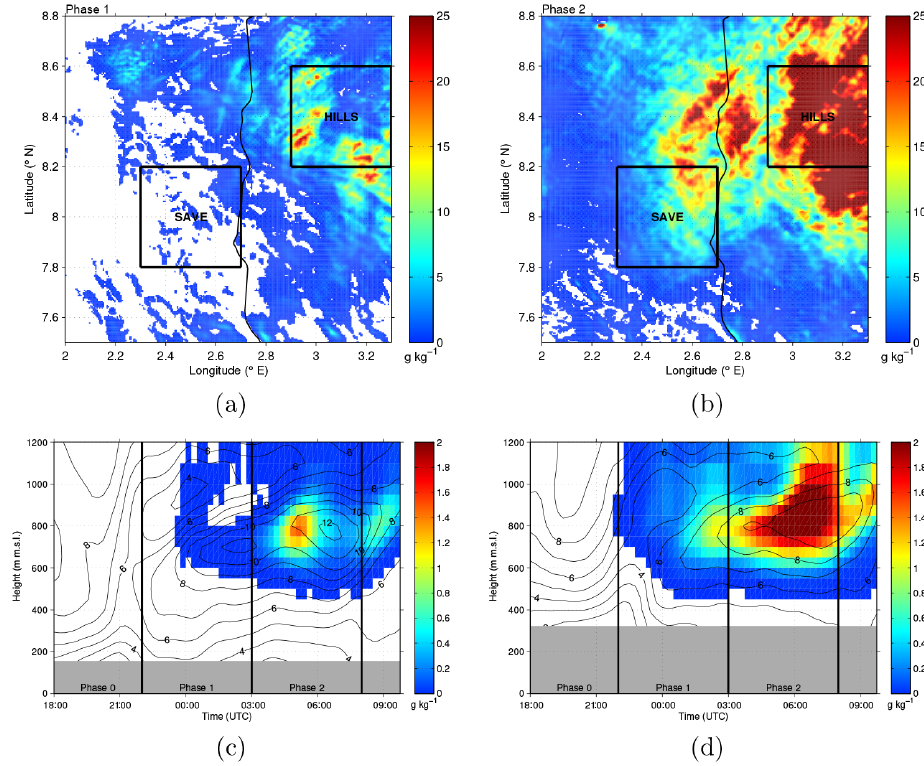
Figure 2. Spatial distribution of the liquid water content accumulated below 1200mm.s.l. averaged between 22:00 and 03:00UTC ( a ; phase 1) and between 03:00 and 08:00UTC ( b ; phase 2) and temporal evolution of the liquid water content (colour-coded) and hori- zontal wind in ms − 1 (black contours) profiles averaged for SAVE (c) and HILLS (d) . Grey shaded areas in (c) and (d) mark the mean terrain